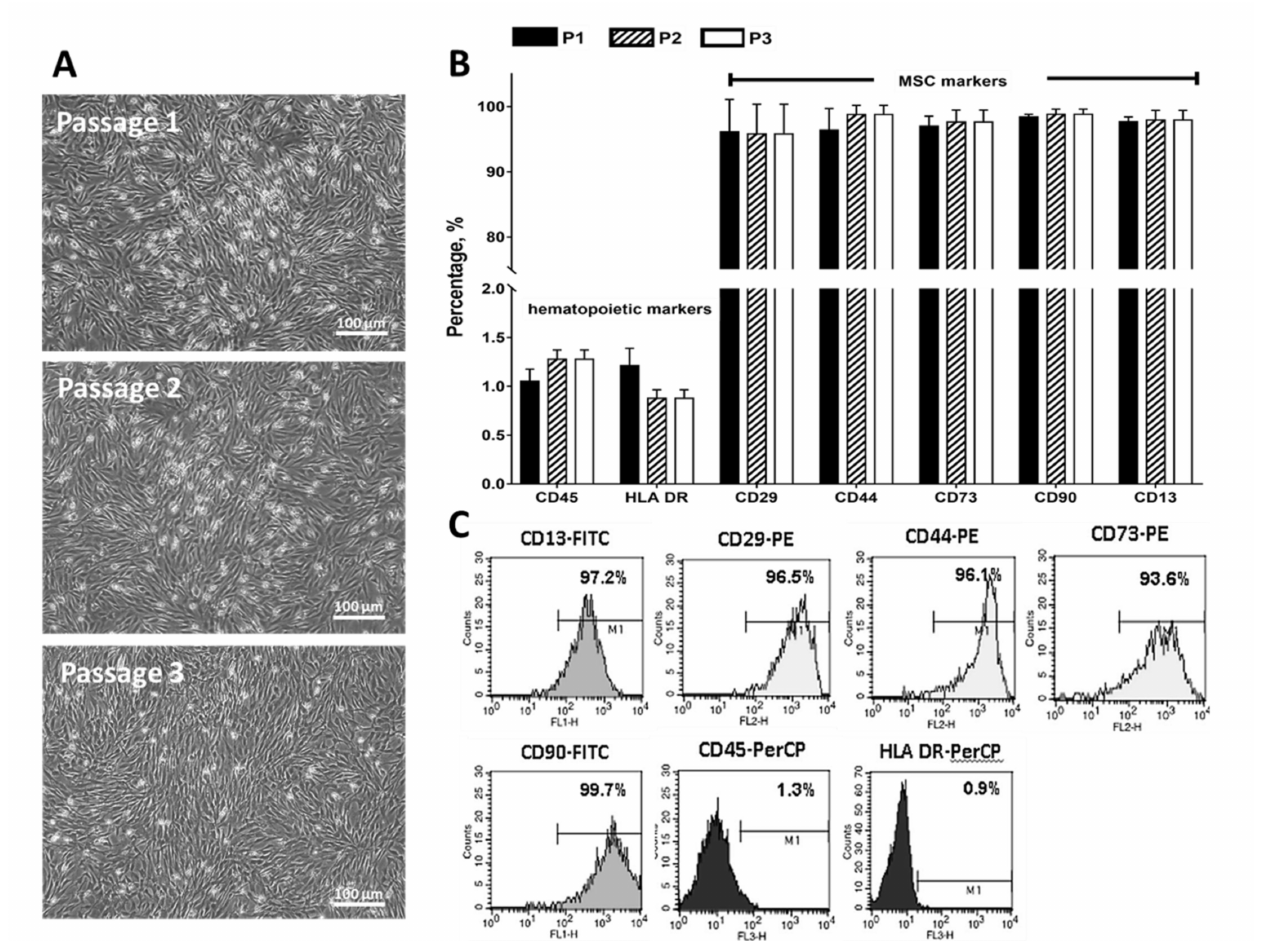
Figure 1. Characterization of Bone-Marrow Stem cells. ( A ) Morphology of MSCs in 7 days of culture at different passages under the light microscopy. ( B , C ) Percentage and flow cytometric analysis of MSCs surface markers were tested at passage 1 according to the ISCT guidelines. Scale bars indicate 100 µ